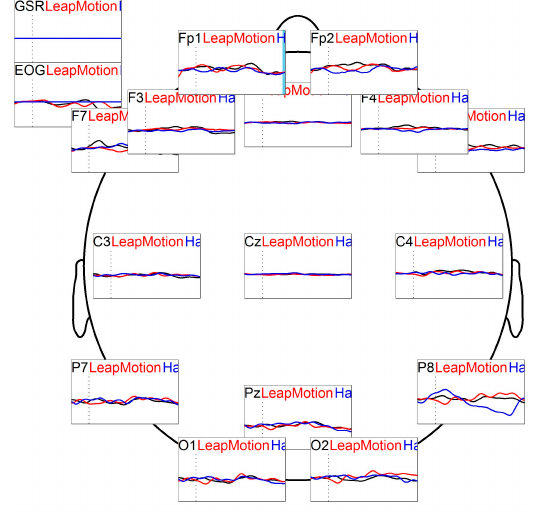
Figure 8. Grand average-matching ERP: black line represents the response of the task after motor imagery training; the red line represents the response after the task of leap motion training, and the blue line represents the response after haptic training. This matching is the ERP trend of the three conditions during the task in all channels recorded.